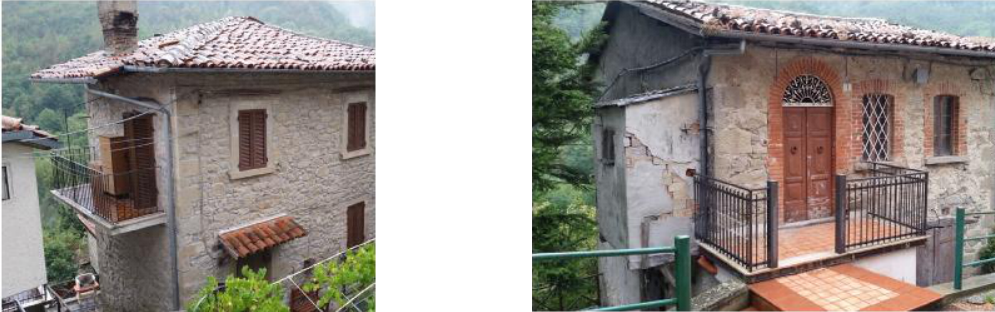
Figure 6: a) Buildings with good quality corners, b) Building with badly constructed